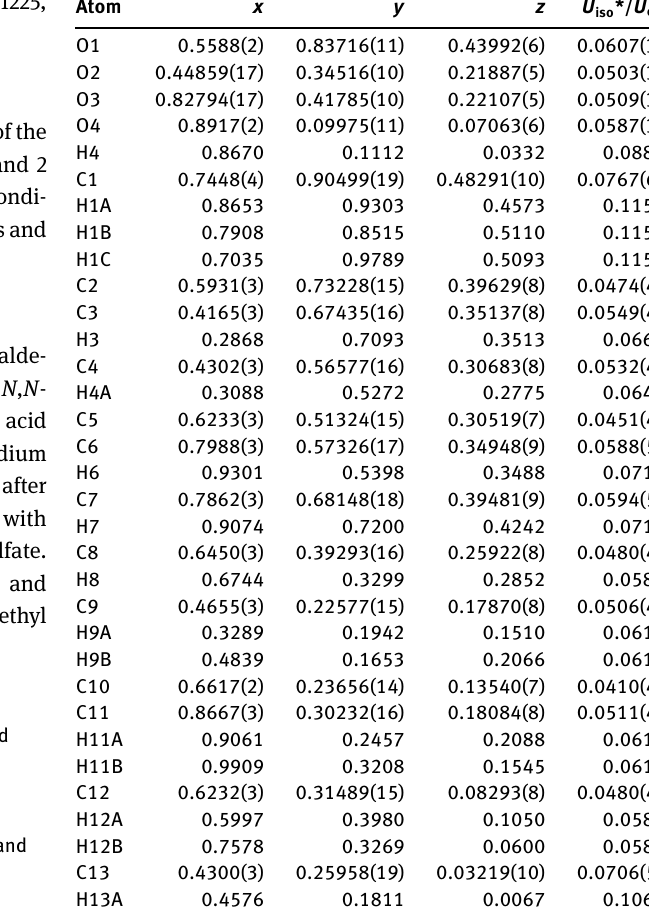
Table 2: Fractional atomic coordinates and isotropic or equivalent isotropic displacement parameters (Å 2